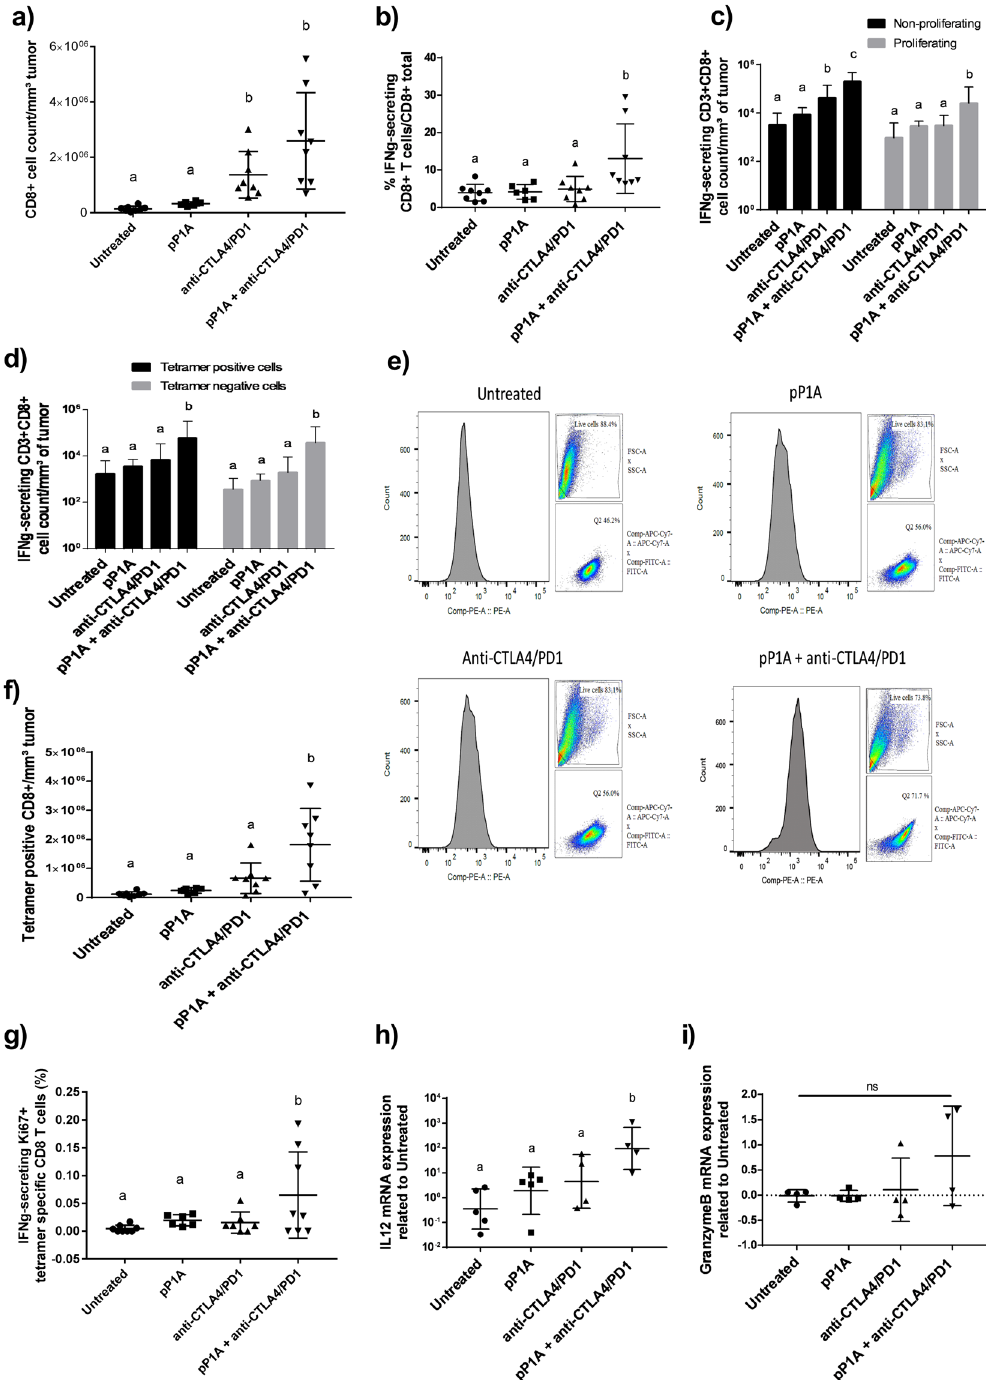
Figure 3. Evaluation of CD8 T cell infiltration, specificity and activity in tumors. ( a ) Number of total CD8 T cells in the tumor (n = 6–8). ( b ) Percentage of IFNg-secreting CD8 T cells compared to the total number of CD3 + CD8 + cells (n = 6–8). ( c ) Number of proliferating (Ki67 + ) and non-proliferating (Ki67 − ) IFNg-secreting CD8 T cells per mm³ of tumor (n = 6–8). ( d ) Number of tetramer-positive and -negative IFNg-secreting CD8 T cells per mm³ of tumor (n = 6–8). In ( c ) and ( d ), two independent statistical analyses have been performed for non- proliferating and proliferating cells or for tetramer positive and tetramer negative cells. ( e ) Representative images of flow cytometry analysis for tetramer-specific CD8 T cells in the single tumor cell suspension. Gating strategy: singlets → live cells → CD3 + CD8 + cells → tetramer + cells. ( f ) Antigen-specific CD8 T cells per mm³ of tumor. ( g ) Percentage of P1A antigen-specific IFNg-secreting and proliferating CD8 T cells per mm³ of tumor. ( h ) qPCR analysis of IL12 mRNA expression related to untreated group (n = 4–5). ( i ) qPCR analysis of Granzyme B mRNA expression related to untreated group (n = 4). All results are expressed as the mean ± SD and were considered statistically significant when p < 0.05 (indicated by the lack of common superscript letters) according to one-way